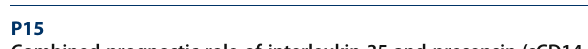
P15 Combined prognostic role of interleukin-35 and presepsin (sCD14 subtype) in clinical setting of sepsis and septic shock